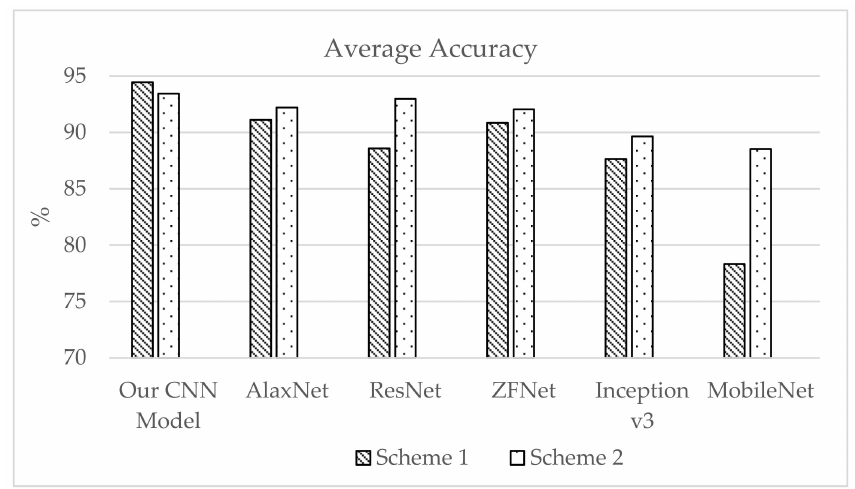
Figure 23. Average test